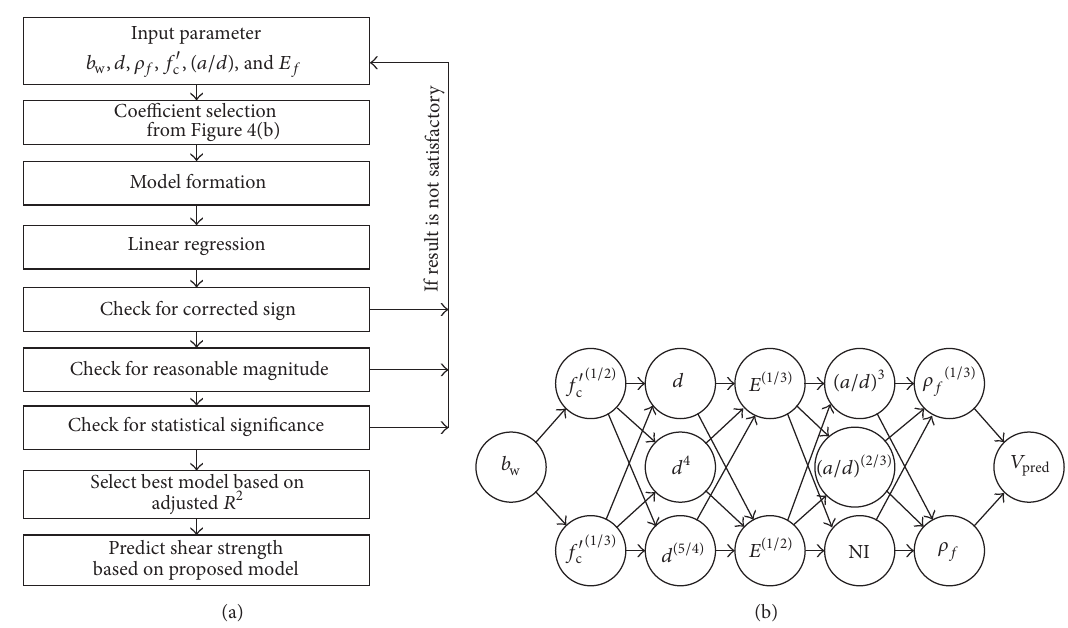
Figure 4: (a) Algorithm to develop proposed model and (b) network used for coefficient selection (NI: not included).